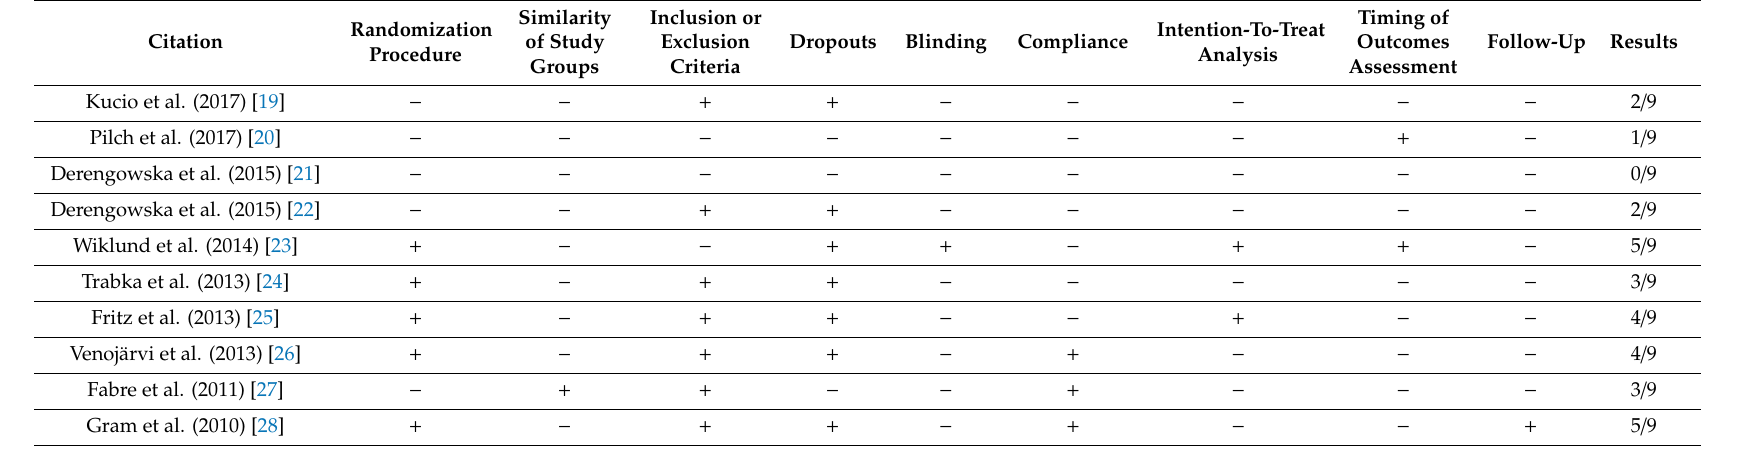
Table 1. Quality assessment of the included